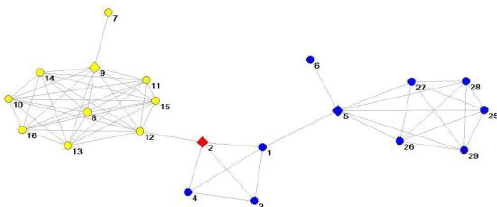
Fig.7. The deconstruction of Marc's network, stage 1 (initial) The centralities during the initial stage 1 are, in descending order: 2 (0.526), 12 (0.521), 1 (0.479), 5